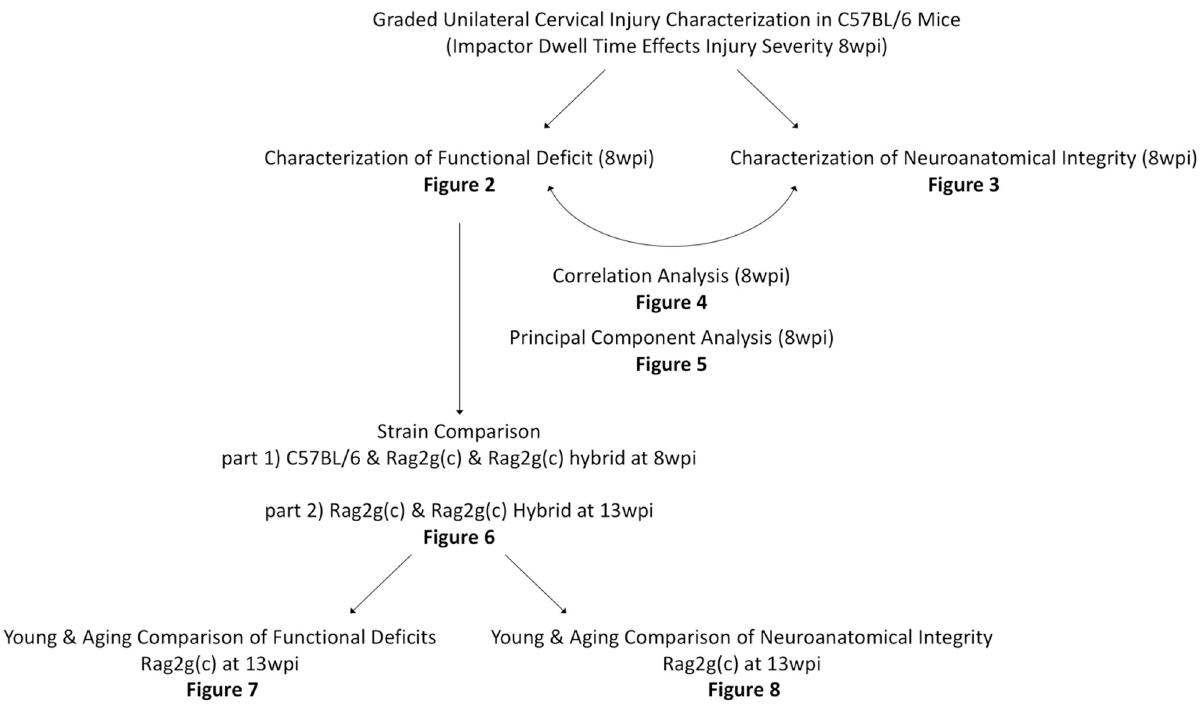
Fig 1. Experimental approach overview. The study design and corresponding figures are illustrated via flow chart, highlighting where data has been pooled between multiple figures.